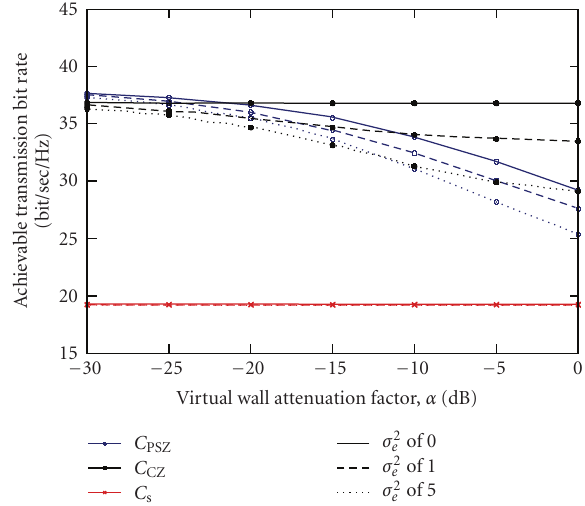
Figure 10: Median value of achievable bit rate using measured 8 × 2 channel